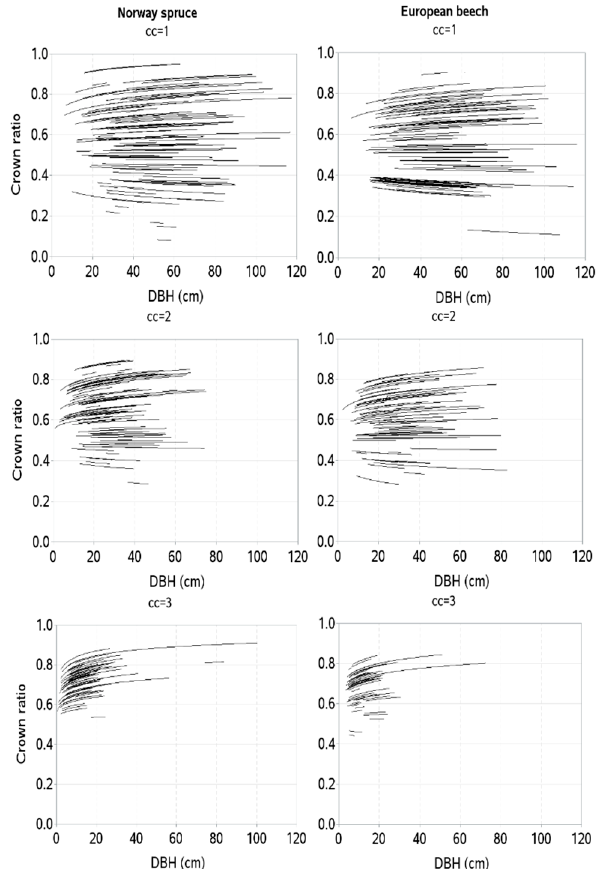
Figure 6. Sample-plot-specific crown ratio curves plotted against diameter at breast height (DBH) for each canopy height class (CC). First panel represents for CC1 (height greater than 66% of the tallest tree), second panel for CC2 (height between 33% and 66% of the tallest tree), and third panel for CC3 (height less than 33% of the tallest tree). Curves were produced using parameter and variance estimates. Sample-plot means in the data were used for all predictors in the model except height to crown base (HCB), which ranged from approximately lowest to highest values by 5 m interval. Random effects were estimated with crown measurements of a sub-sample of four randomly selected trees of the species of interest per sample plot in a part of the model fitting dataset.